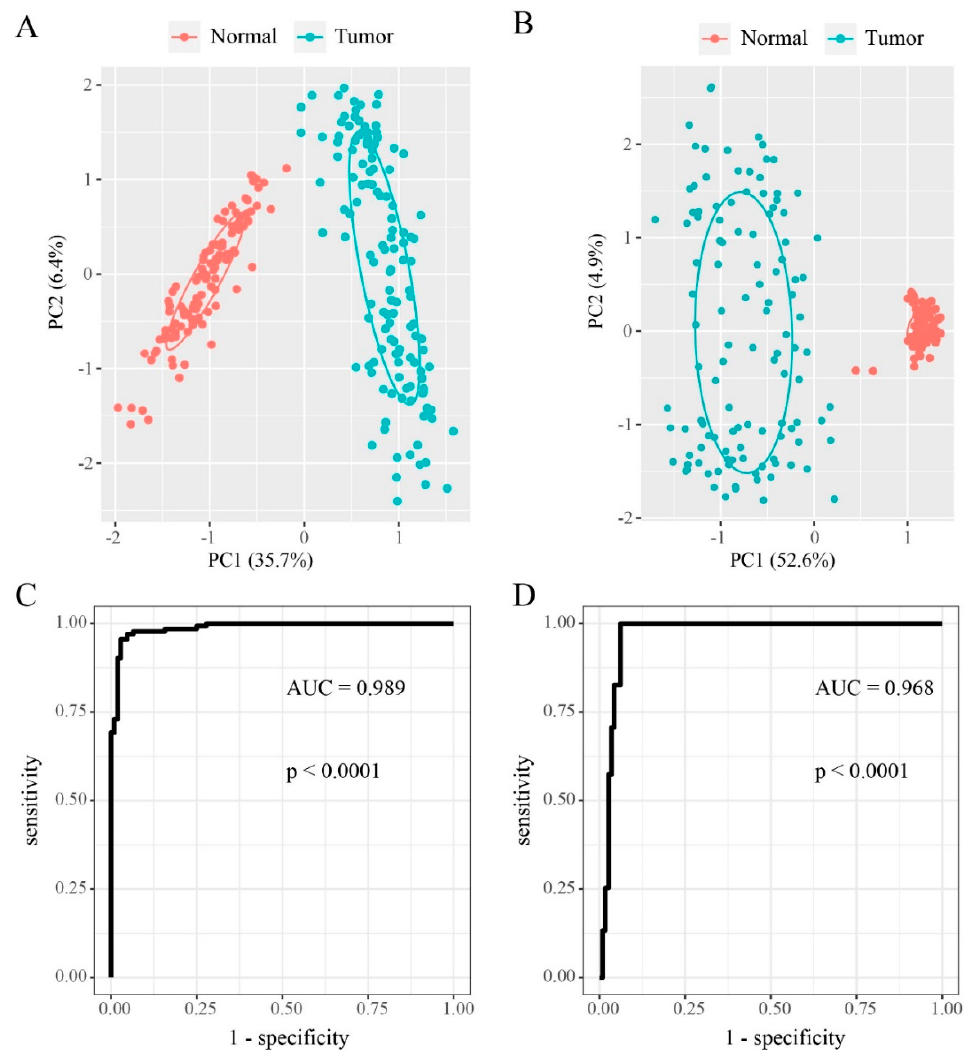
Figure 5. Prediction of “EGFR Wild Type / Low PD-L1 expression” NSCLC by DNA methylation and gene expression pattern. ( A , B ) Principal component analysis (PCA) analysis for “EGFR Wild Type / Low PD-L1 expression” NSCLC and normal samples by the 249-DMEGs and 297-DMSs predictors, respectively. ( C , D ) Receiver operating characteristics (ROC) displaying the classification accuracy of 249-DMEGs predictor and 297-DMSs predictors, respectively.